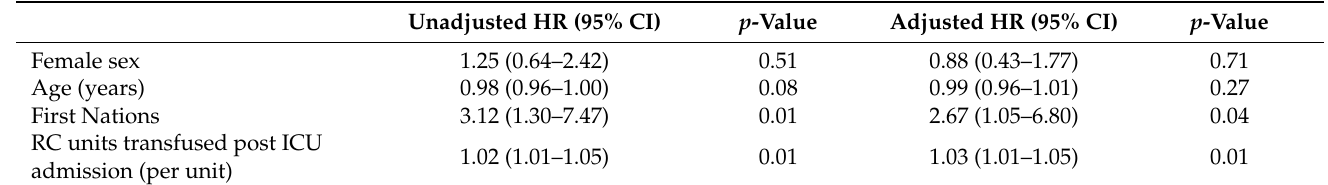
Table 6. Alloantibody positivity 2015–2019: univariable and multivariable Cox proportional hazards regression of new incident clinically significant RC alloantibody-positive versus -negative patients admitted to ICUs in NT between 2015–2019.